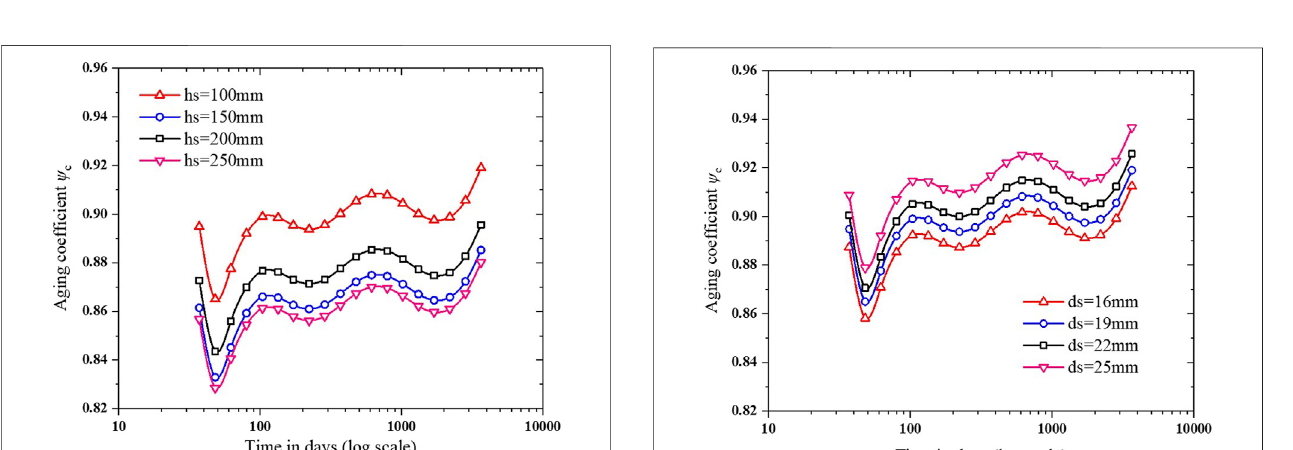
FIGURE 7 | Time dependent relative slip with increasing stud diameter.